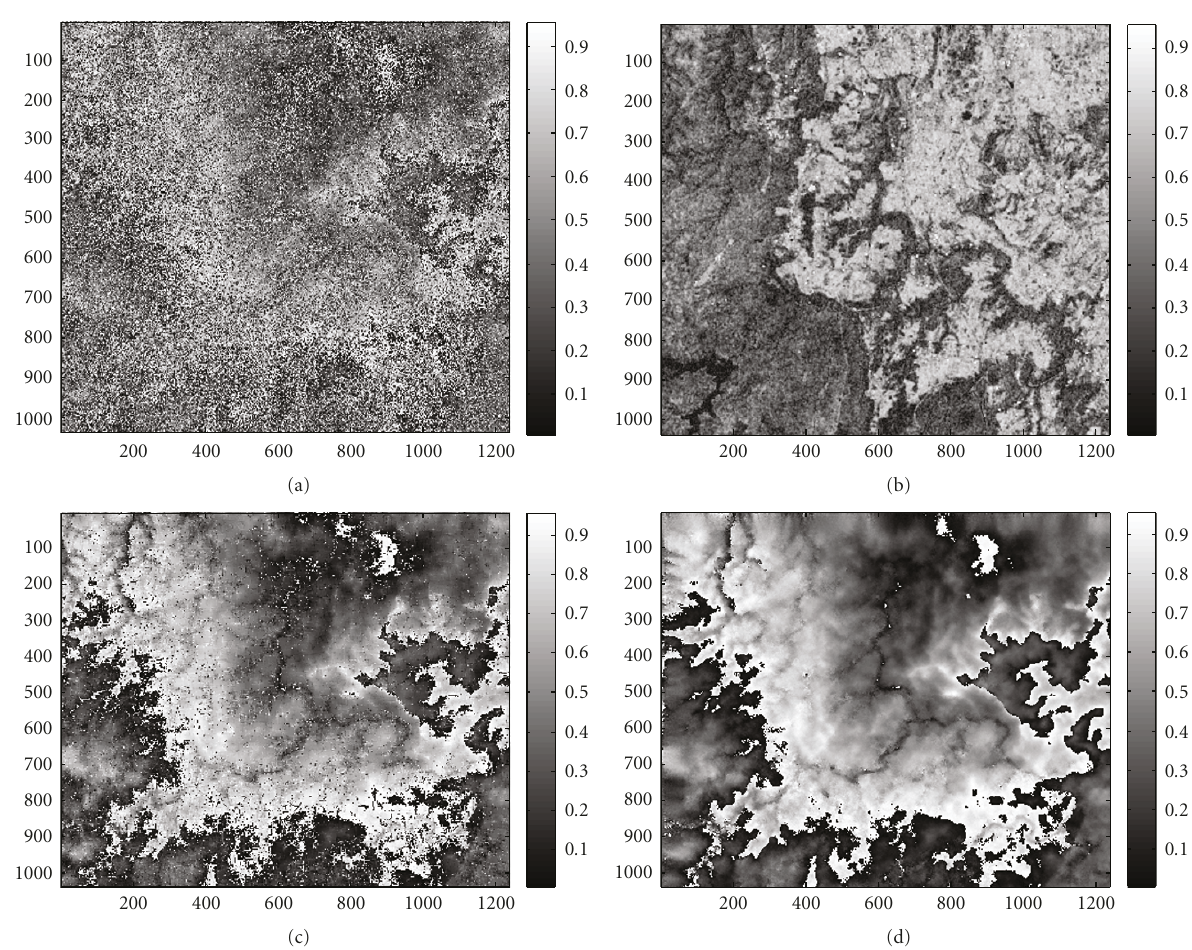
Figure 3: (a) Topographic fringes of an area over Appin, Australia from ERS-1/2 tandem mission: original interferogram (1037 × 1238), (b) coherence map corresponding to the interferogram, (c) median filtered interferogram—used as the reference image, (d) filtered image using proposed technique.